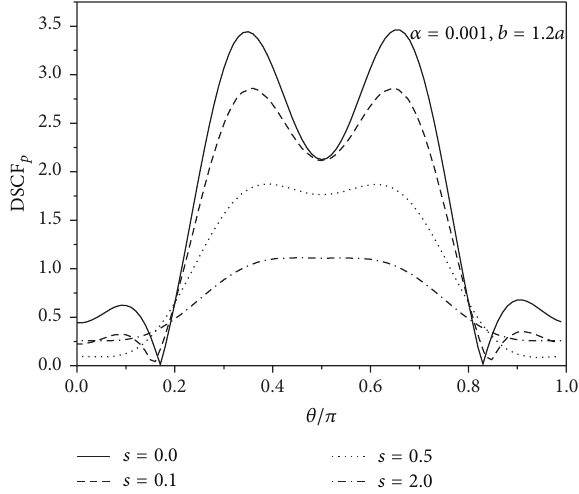
Figure 4: Surface effect on the distribution of DSCF along the middle hole for 𝛼 = 0.001 and 𝑏 = 1.2𝑎